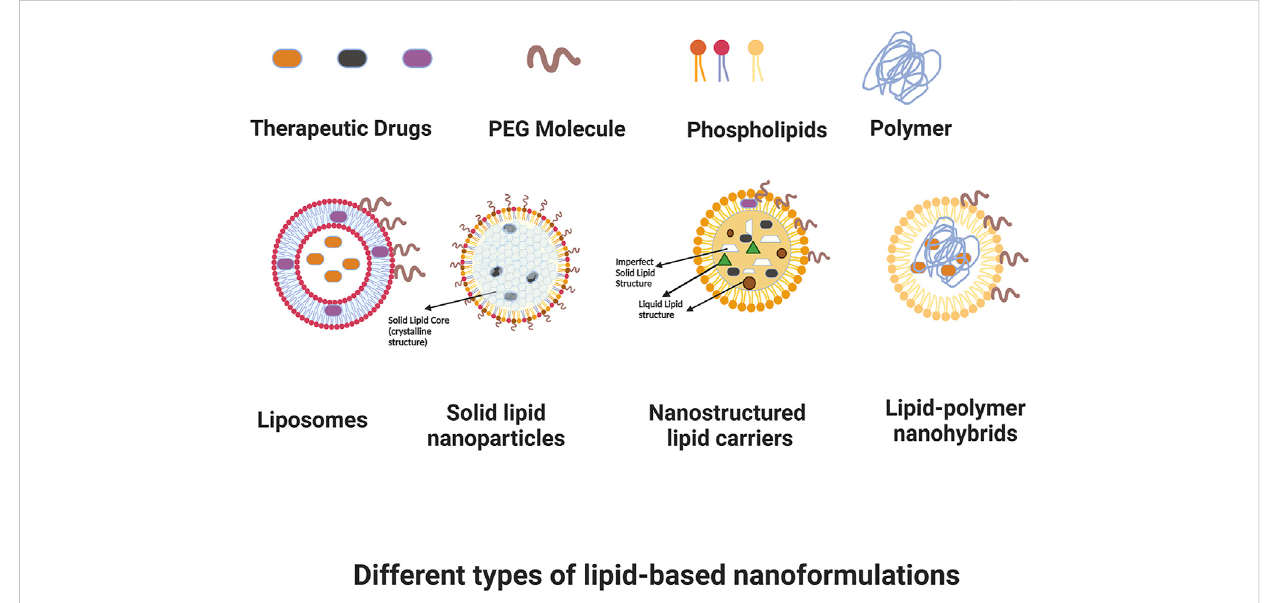
FIGURE 1 Some types of lipid-based nanoformulations. Created with